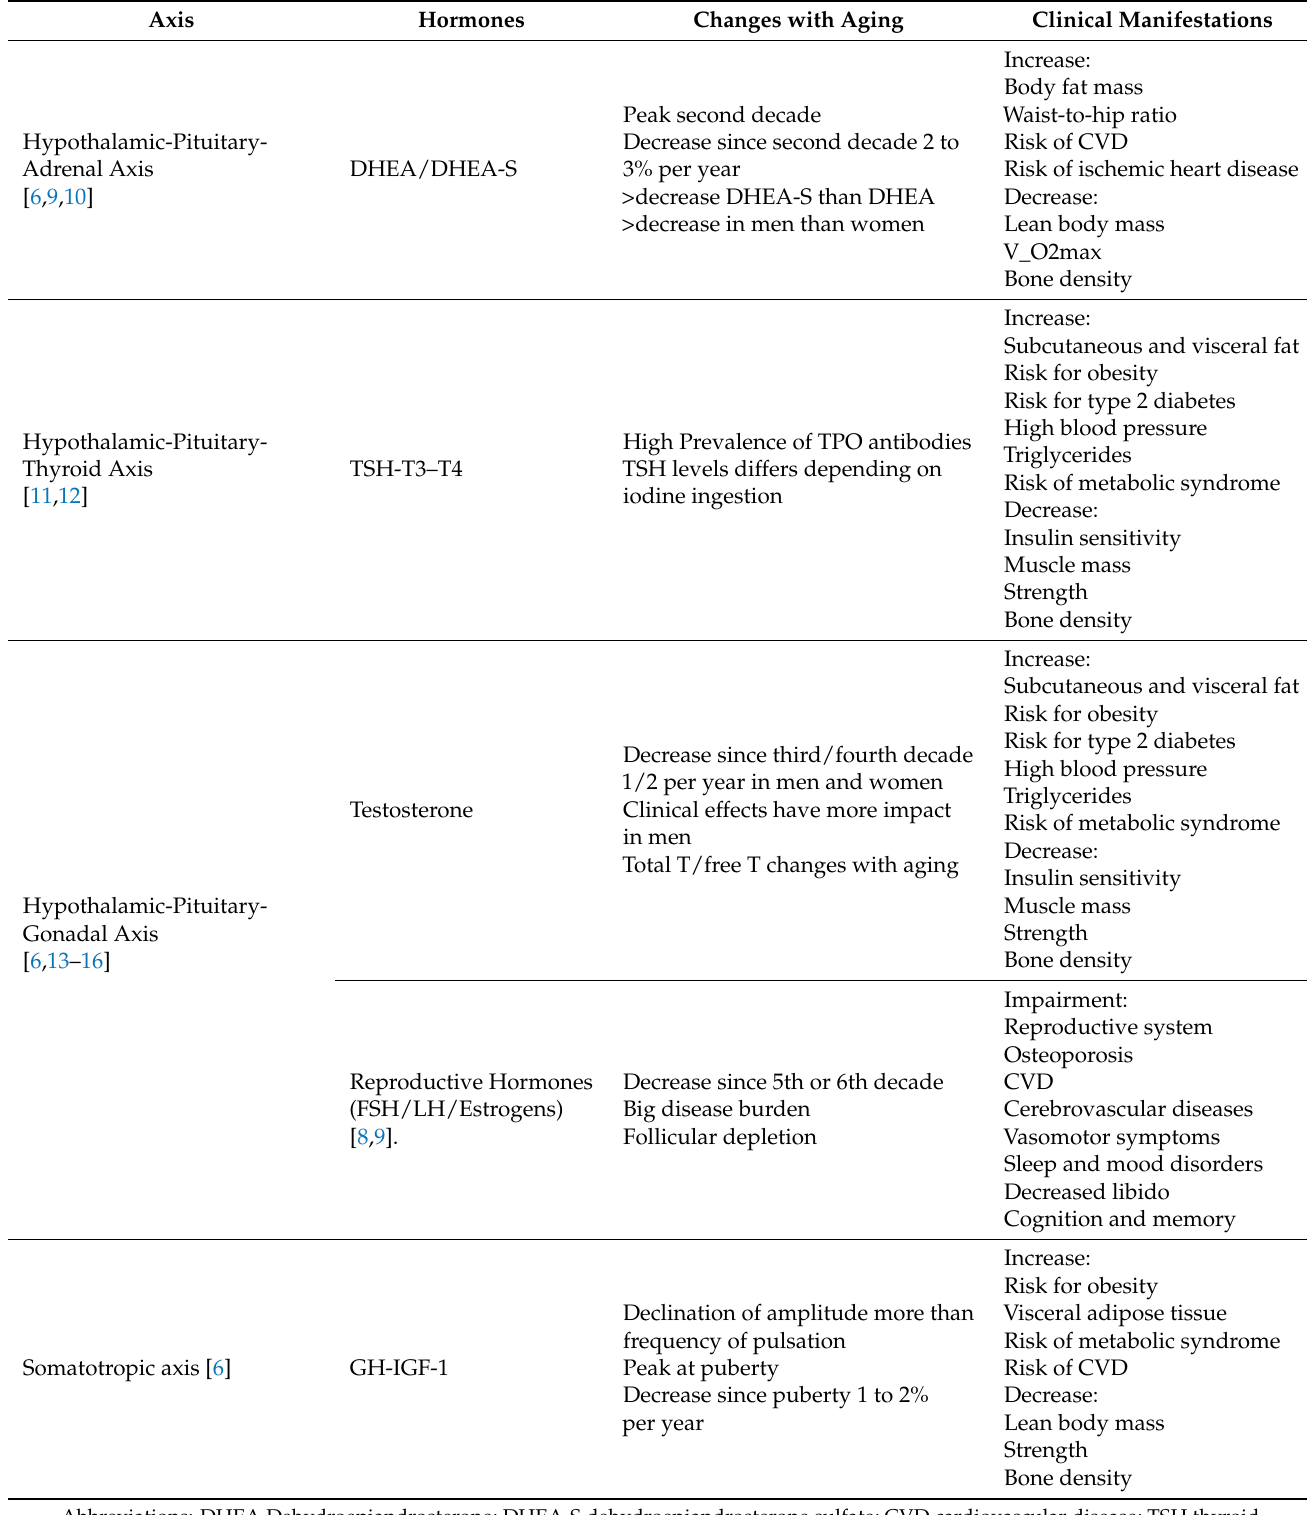
Table 1. Summary of metabolic changes and clinical manifestations in the